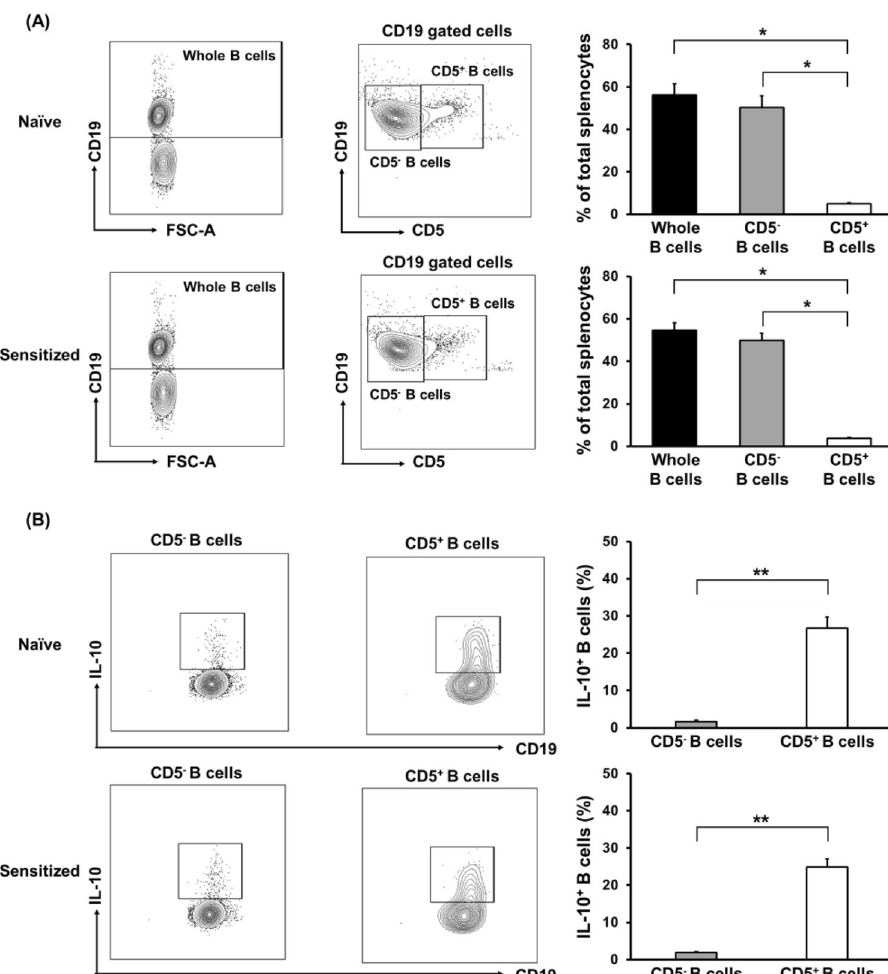
Figure 6. Analysis of CD5 + B cells and CD5 - B cells in naïve and sensitized mice splenocytes. ( A ) To investigate the phenotypic characteristic of B cells, splenocytes from either naïve or sensitized Balb/c mice were stained with anti-CD5 and anti-CD19 mAb. Representative FCM profiles are shown on the left column. The abundance ratios of whole B cells, CD5 - B cells, and CD5 + B cells from five independent experiments are shown on the right column. Upper column, naïve Balb/c mice; lower column, sensitized Balb/c mice, * p < 0.05. ( B ) To investigate the IL-10-positive B cells, splenocytes from either naïve or sensitized Balb/c mice were cultured with PMA, ionomycin, and monensin for 5 h and stained with anti-CD5 and anti-CD19 mAb. After permeabilization, the cells were stained with anti-IL-10 mAb. Representative FCM profiles are shown on the left column. The abundance ratios of IL-10-positive CD5 + B cells and CD5 - B cells from five independent experiments are shown on the right column. Data are presented as mean ± SEM. Upper column, naïve Balb/c mice; lower column, sensitized Balb/c mice, ** p <